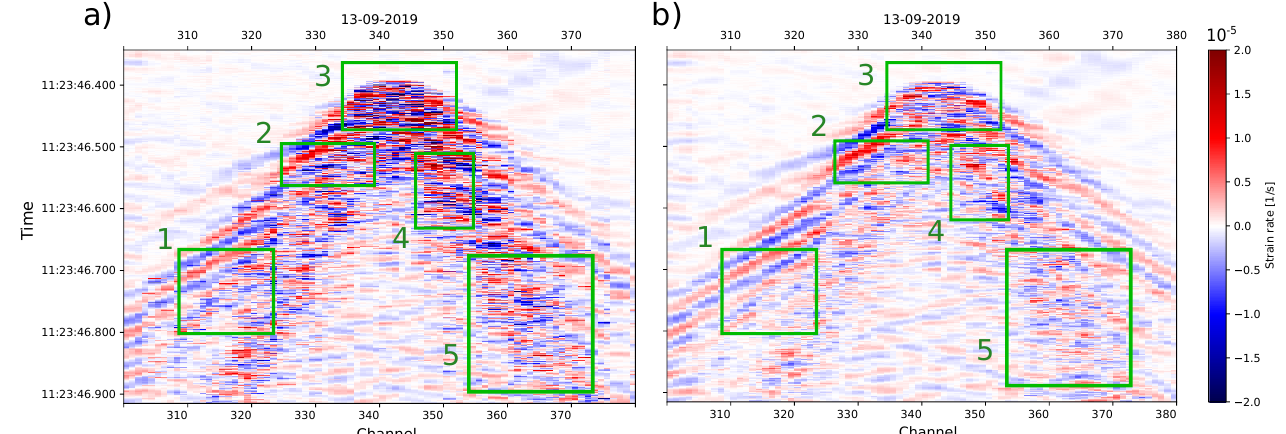
Figure 9. DDSS data example of a tap test (same as in Figure 4) for ( a ) fiber instance one and ( b ) stack instance five. Noticeable differences are indicated within the green boxes where the signal has been smoothed and due to random noise reduction.